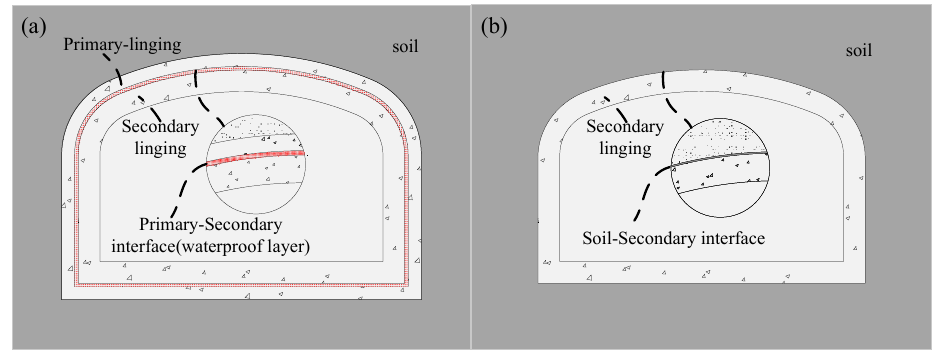
Figure 5. Contact interface schematic ( a ) with primary lining ( b ) without primary lining.